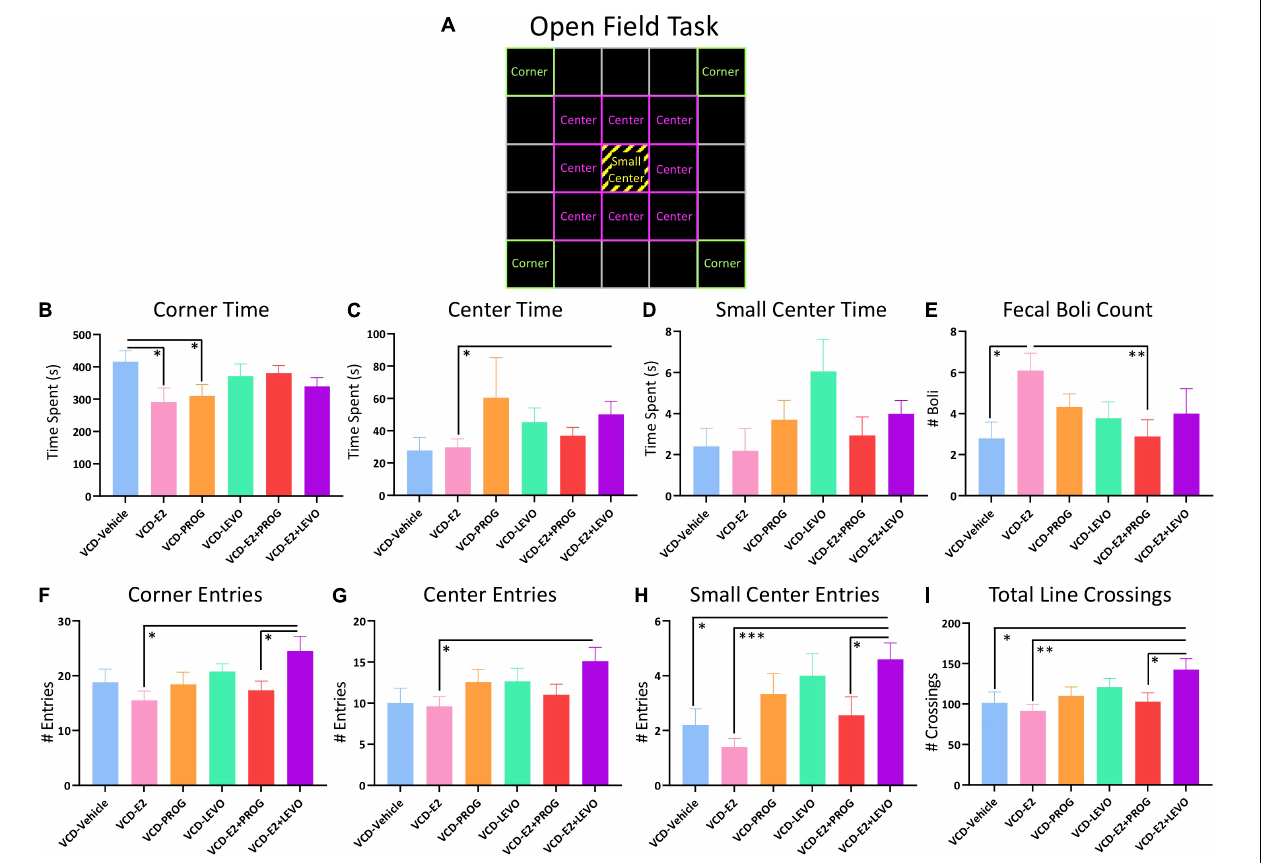
FIGURE 10 | Open Field Task. (A) Schematic of the OFT arena. Green squares indicate which boxes were defined as Corners, pink squares indicate which boxes were defined as Center, and yellow stripes indicate the Small Center, which was also included in the “Center” measure. (B) The VCD-Vehicle group spent more time in the corners compared to VCD-E2 and VCD-PROG groups. (C) VCD-E2 + LEVO treatment increased time spent in the center compared to VCD-E2 treatment. (D) No significant differences in Small Center Time were detected. (E) The VCD-E2 group had more fecal boli than the VCD-Vehicle and VCD-E2 + PROG group. (F) The VCD-E2 + LEVO group made more entries into the corner compared to the VCD-E2 group as well as the VCD-E2 + PROG group. (G) The VCD-E2 + LEVO group made more entries into the center compared to VCD-E2 treatment alone. (H) The VCD-E2 + LEVO group made more entries into the small center